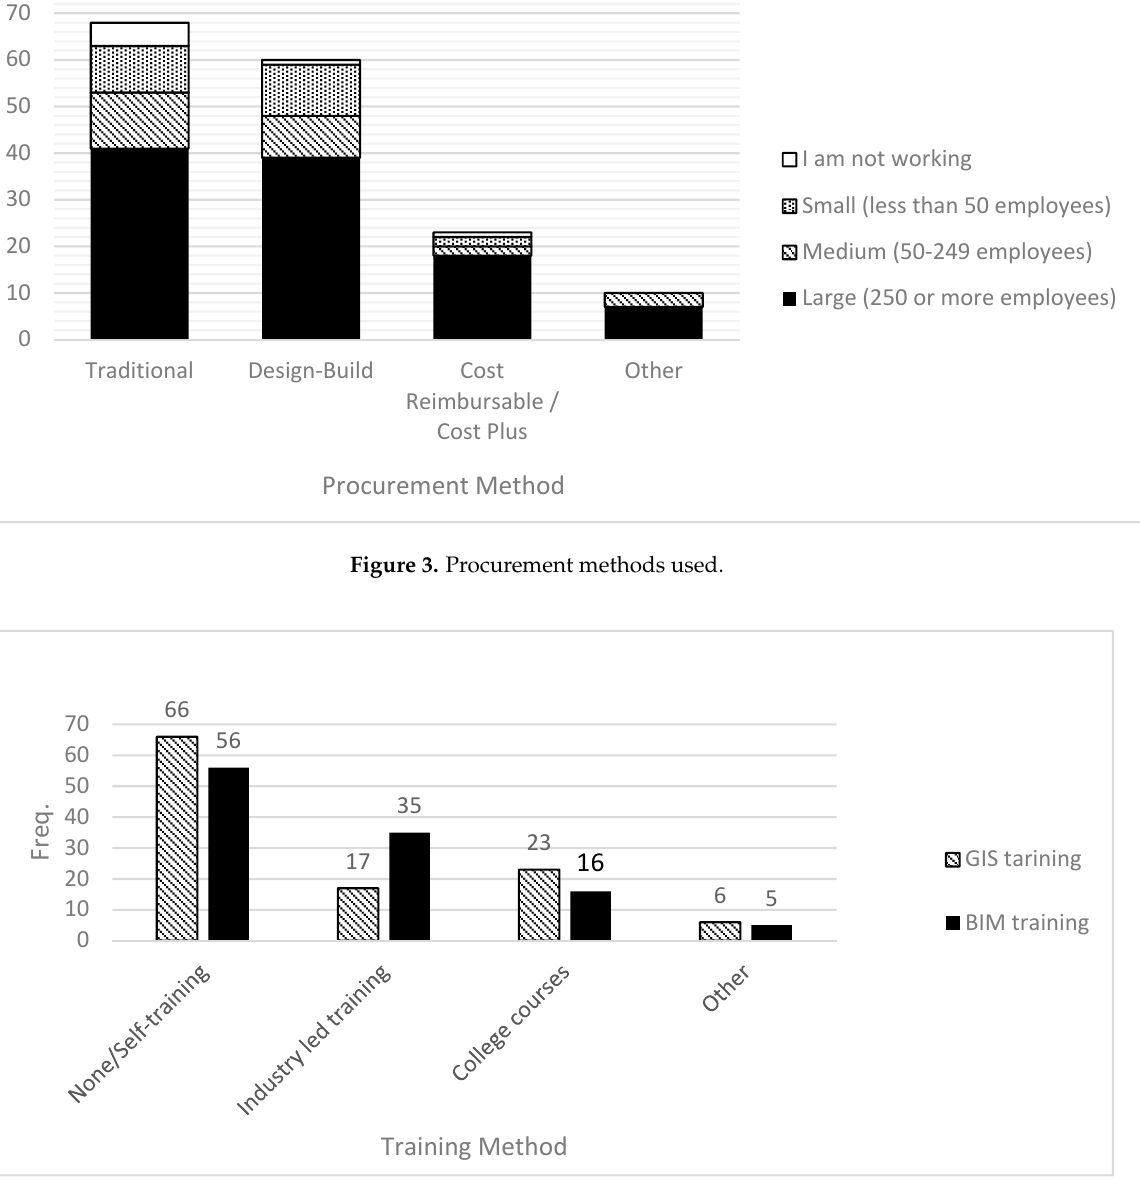
Figure 4. BIM and GIS Training Method.